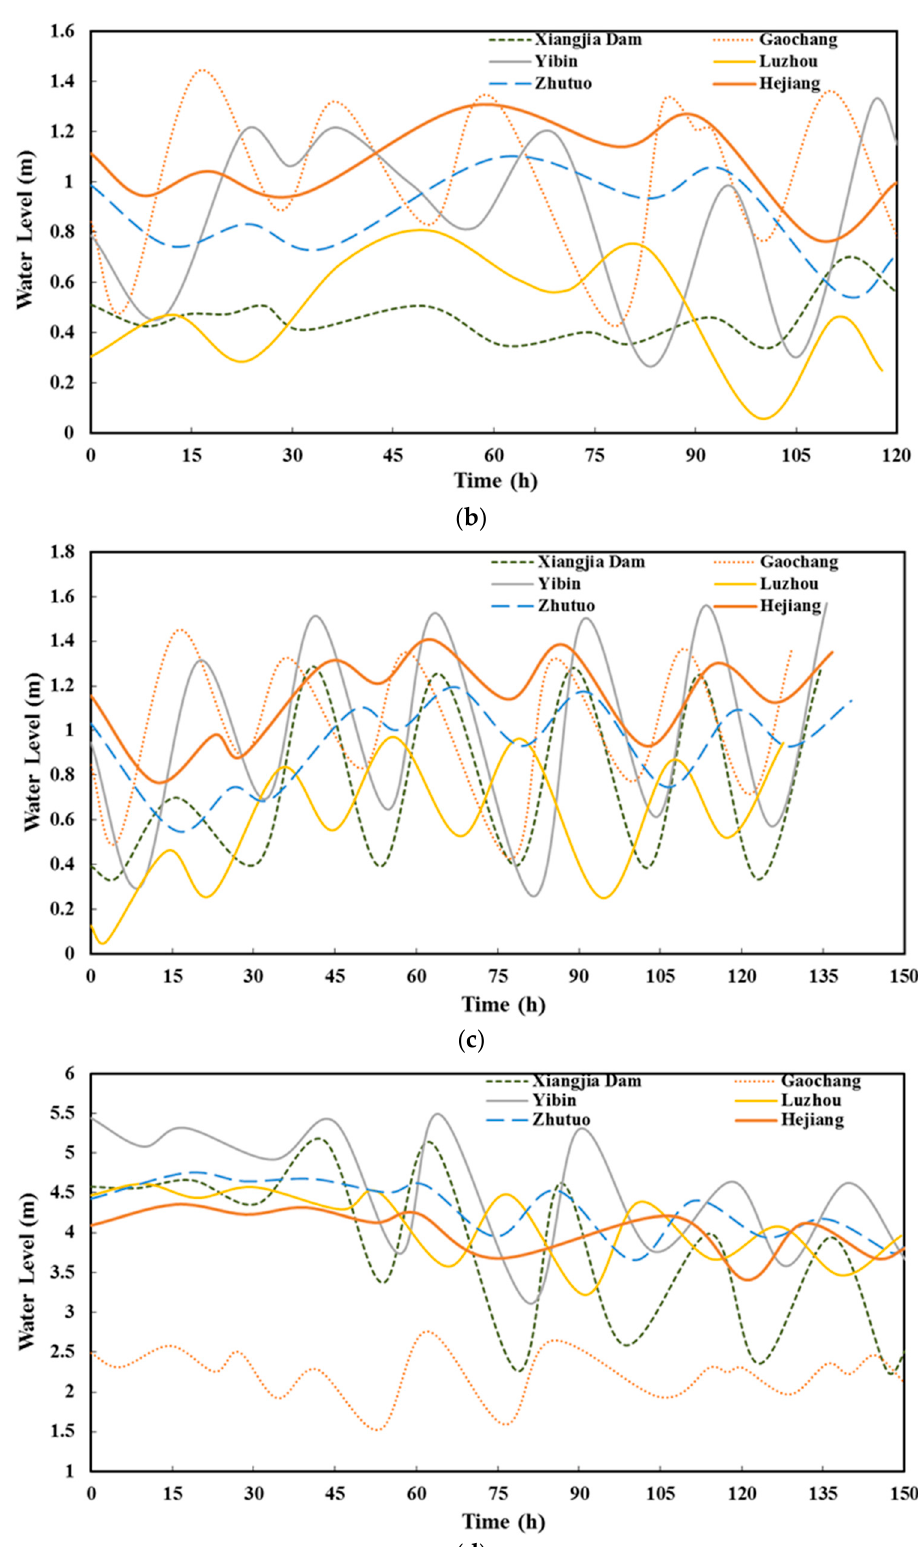
Figure 6. Recorded water level variations on upstream and downstream gauging stations along the Yangtze River: ( a ) 11–15 February 2013; ( b ) 22–26 February 2013; ( c ) 26 February–3 March 2013; and ( d ) 20–27 October 2014. (Reference datum: Gaochang ∇ 273.13 m; Xiangjia Dam ∇ 265.81 m; Yibin ∇ 257.25 m; Luzhou ∇ 222.92 m; Hejiang ∇ 204.87 m; and Zhutuo ∇ 195.00 m).